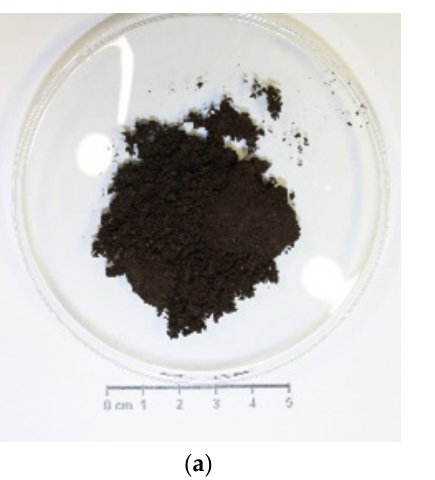
Figure 8. Picture ( a ) and stereo-micrography ( b ) of SIDENOR combustion chamber dust sample. Table 7. Chemical analysis of SIDENOR combustion chamber dust samples.